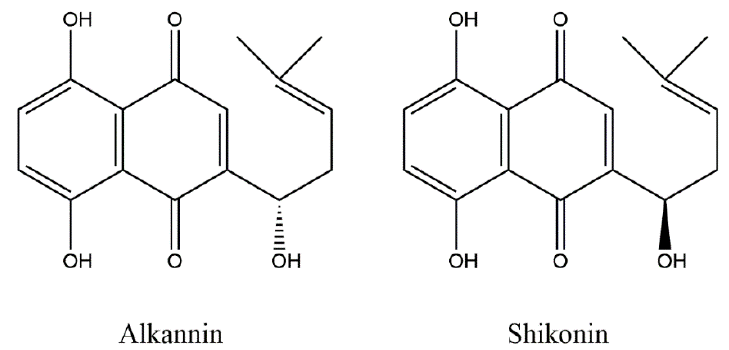
Figure 1. The enantiomers, alkannin and shikonin.